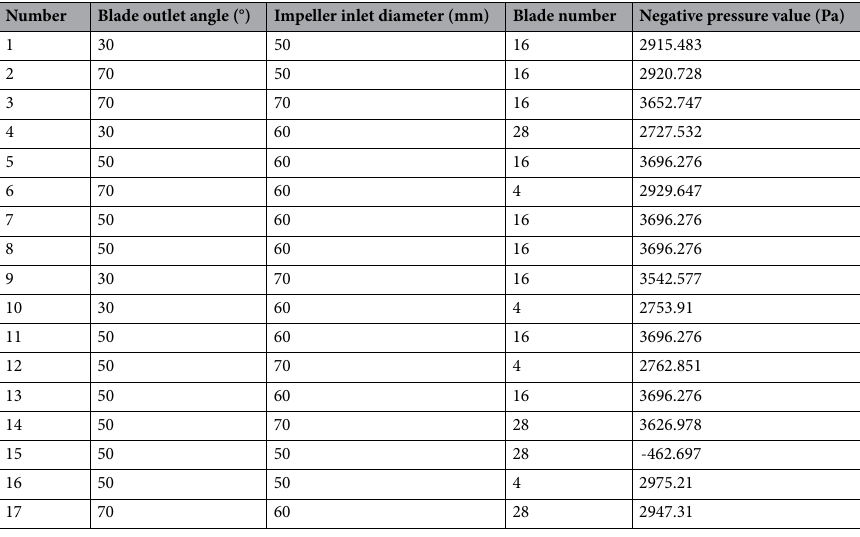
Table 8. Selection of sample points and CFD simulation